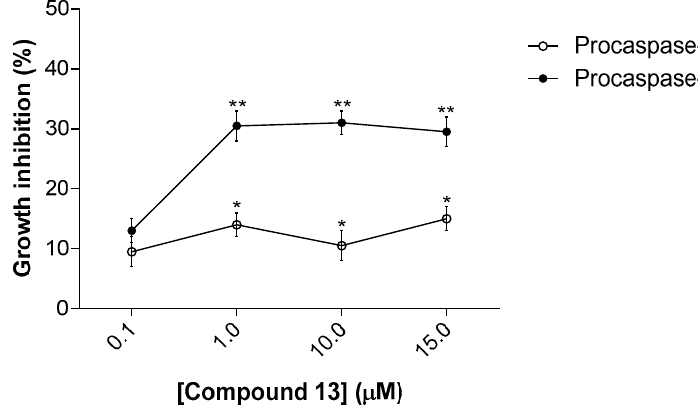
Figure 3. Effect of compound 13 on the growth of yeast cells expressing procaspases-3/7. Concentration-response curves for the effects of compound 13 on the growth of yeast cells expressing human procaspase-7 or procaspase-3, for 24 h treatment. The percentage of drug-induced growth inhibition was estimated considering 100% growth the number of CFU obtained with DMSO only. Data are mean ± SEM of six independent experiments; values significantly different from DMSO are indicated (* p < 0.05, ** p = 0.001; unpaired t-test).